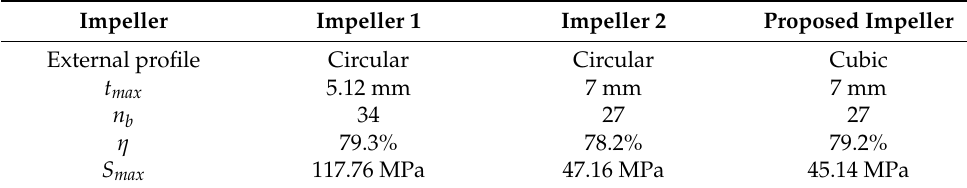
Table 4. Comparison of impellers.